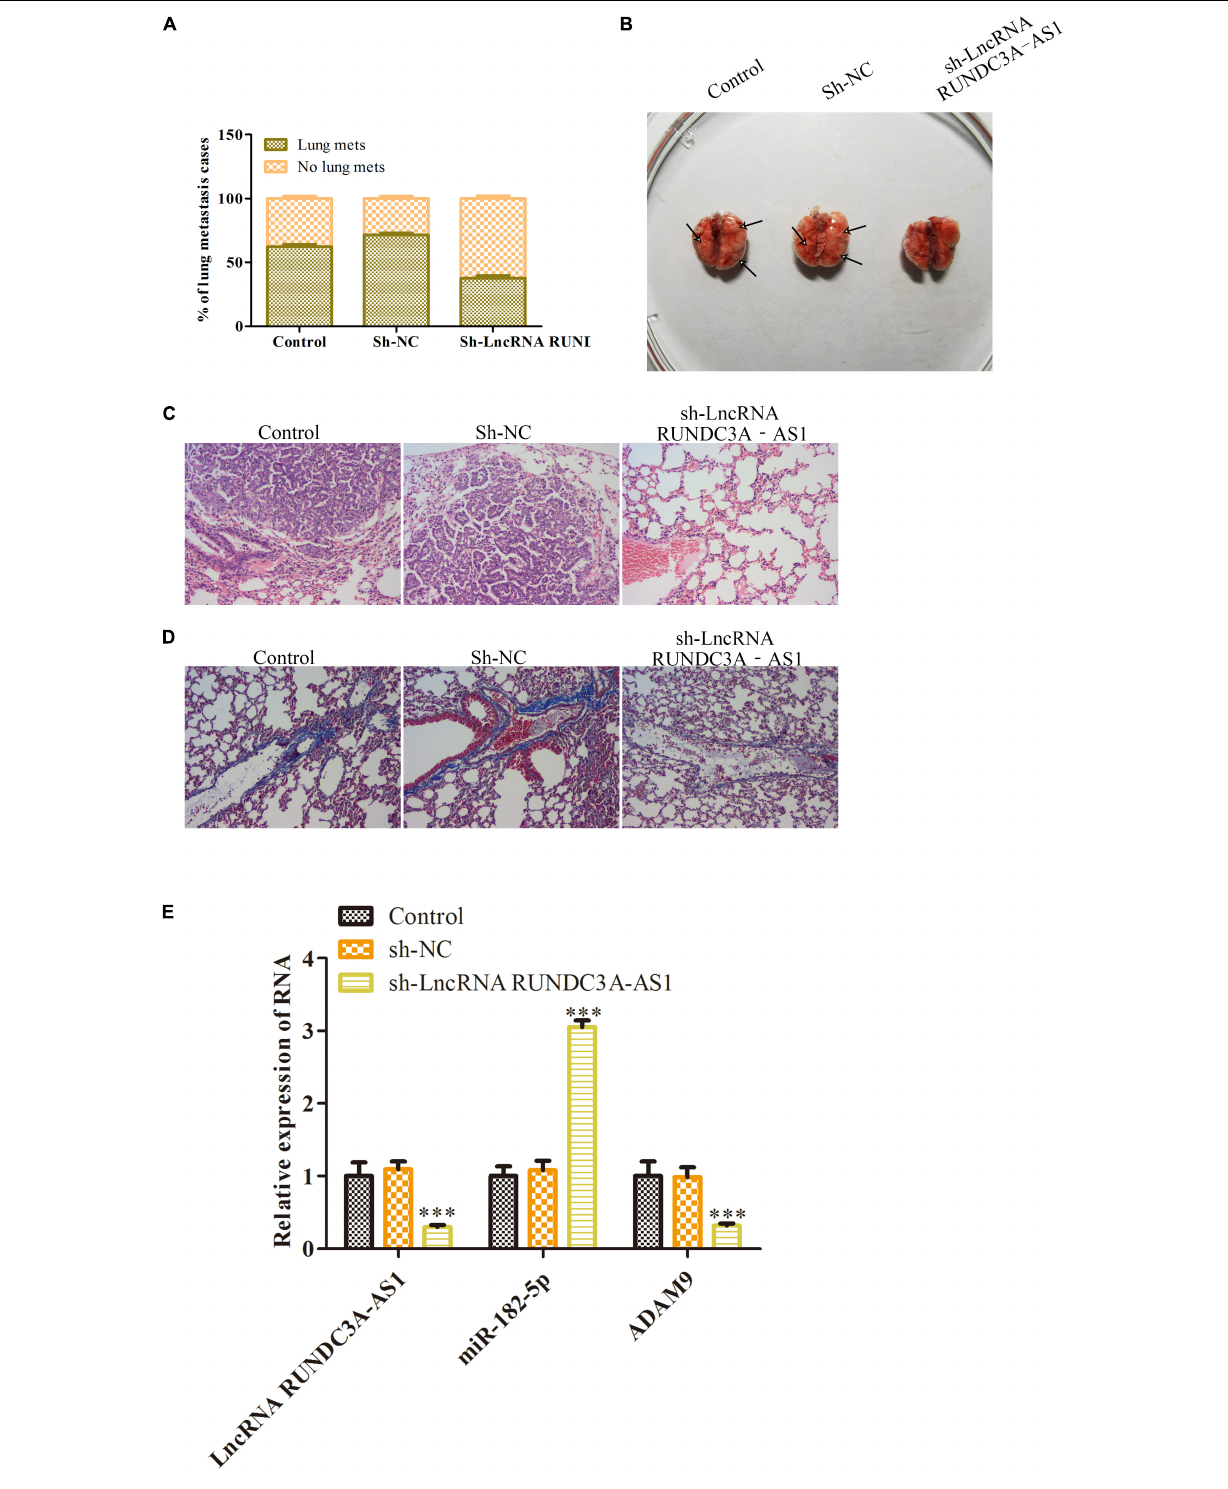
FIGURE 7 | Knockdown of RUNDC3A-AS1 inhibits thyroid tumor metastasis to lung in vivo . K1 cells transfected with sh-RUNDC3A-AS1 and sh-NC were injected into athymic nude mice via the tail vein. (A) The incidence of lung metastasis in K1 thyroid tumor. (B) The images of lung metastasis of sh-NC and sh-RUNDC3A-AS1 groups by stereo fluorescence microscope and lung metastasis analysis of sh-NC and sh-RUNDC3A-AS1 groups. (C) Hematoxylin eosin (HE) staining assay. (D) Masson staining assay. (E) RT-qPCR detected the expression of RUNDC3A-AS1, miR-182-5p, and ADAM9 in indicated groups. *** P < 0.001 vs. the sh-NC